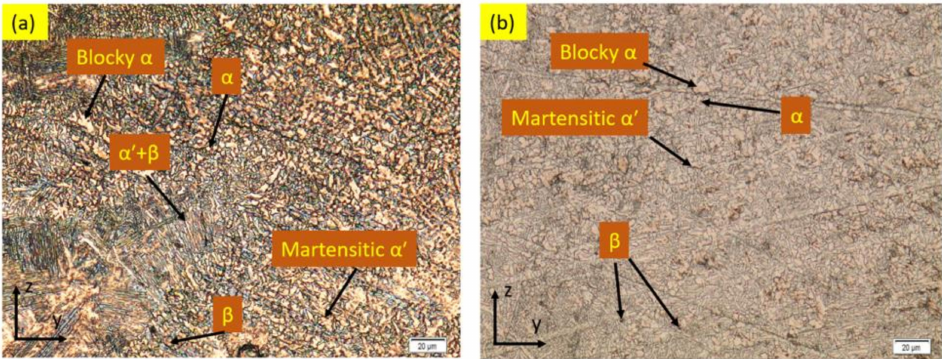
Figure 7. The microstructure of the fusion zones ( a ) in serum medium ( b ) in air medium. The microstructure of the HAZ of the underwater- and air-WM is shown in Figure 8. In both welding environments, the HAZ could be categorized into two distinct areas: near- weld area and the BM zone. The area near the welding zone is composed of the intersecting perpendicular “basket” samples of α + α (cid:48) phase, while the area near the BM consists of α and β phase.